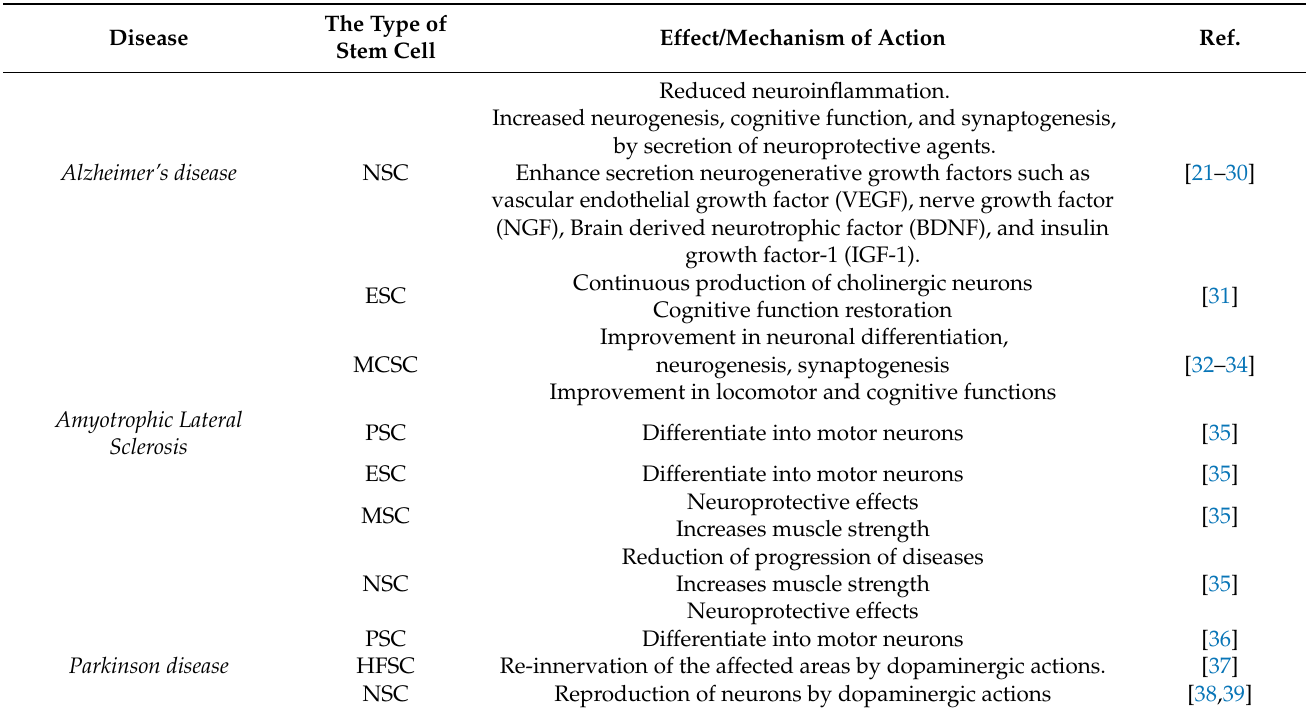
Table 1. A review of stem cell therapy and its effects on neurological diseases.